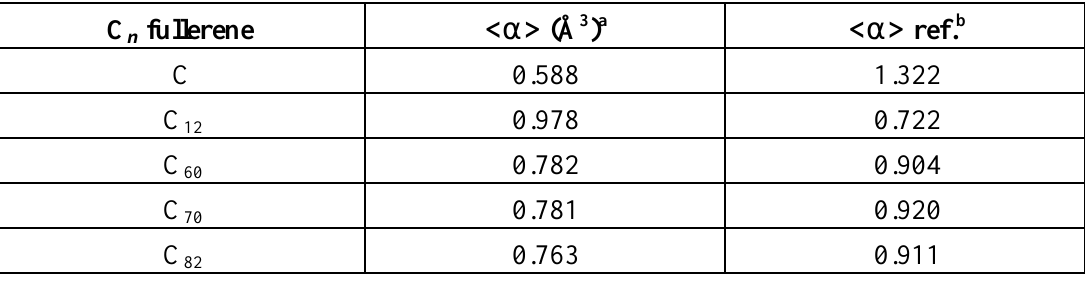
Table 2. Elementary dipole-dipole polarizabilities for fullerene